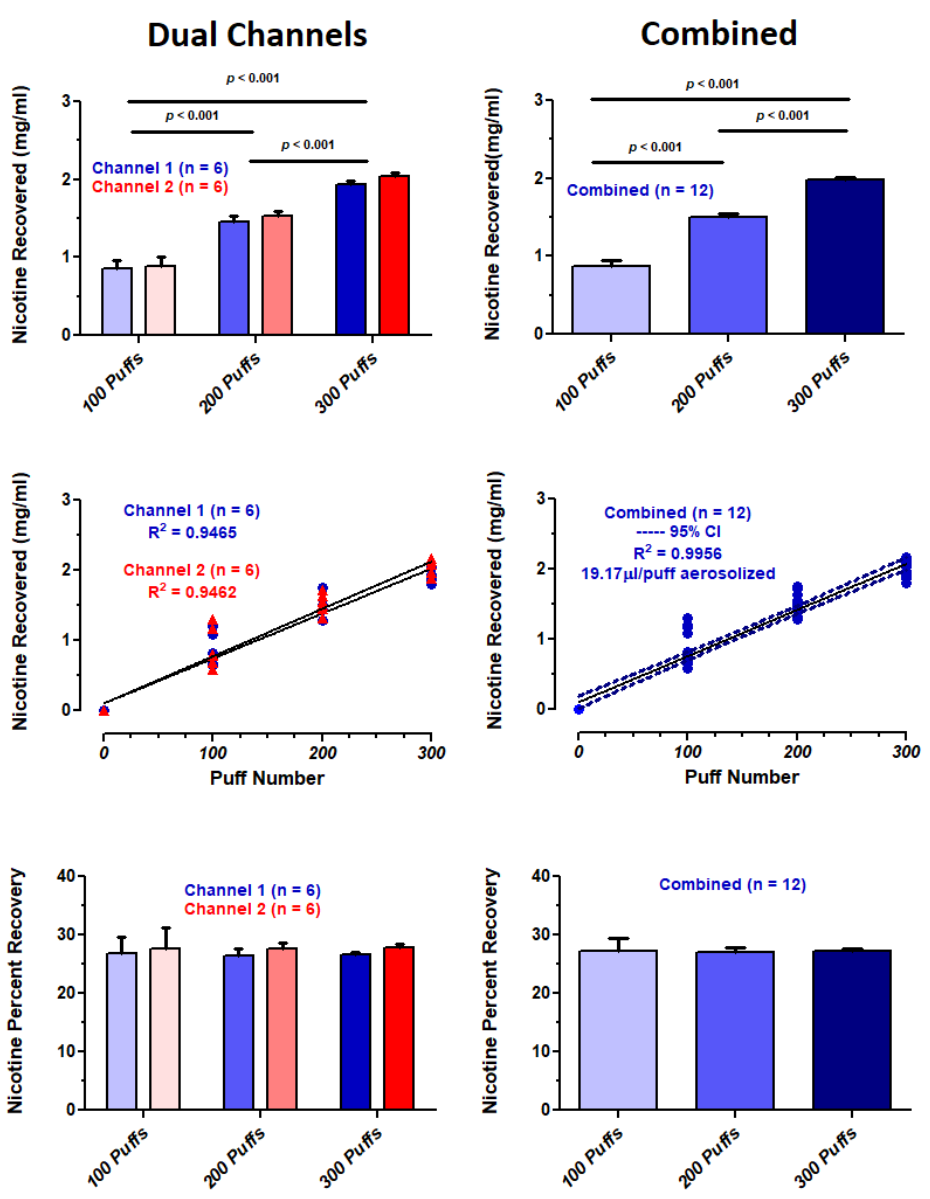
Figure 11. The amount of nicotine recovered after 0, 100, 200 and 300 puffs, as well as the percent recovery of nicotine, using the dual-channel ECIG aerosol generator. The amount of nicotine (mg/mL) recovered as determined by HPLC is multiplied by a dilution factor of twenty. Percent recoveries were determined by dividing the nicotine recovered (values in the middle panels) by the theoretical maximum concentration of nicotine delivered in either 0, 100, 200 or 300 puffs. The the- oretical maximum amount of nicotine in 0, 100, 200 or 300 puffs is based on the amount of aeroso- lized E-liquid (19.17 µL/puff) which is added to the initial 10 mL volume of BHI, thus giving final volumes of 10, 11.92, 13.83 or 15.75 mL, respectively. Since the E-liquid has a nicotine concentration of 20 mg/mL, the theoretical maximum concentrations of nicotine in BHI are 0, 3.22, 5.54 and 7.30 mg/mL for 0, 100, 200 and 300 puffs, respectively. Each bar represents the mean ± SEM. 4. Discussion Commercial ECIG vaping machines and ECIG aerosol generators are currently avail- able, such as the Borgwaldt LM4E (Borgwaldt-Kc, Hamburg, Germany) [8,24], and the Cerulean SM450e (Milton Keys, UK) [9,25], with other machines slowly entering the